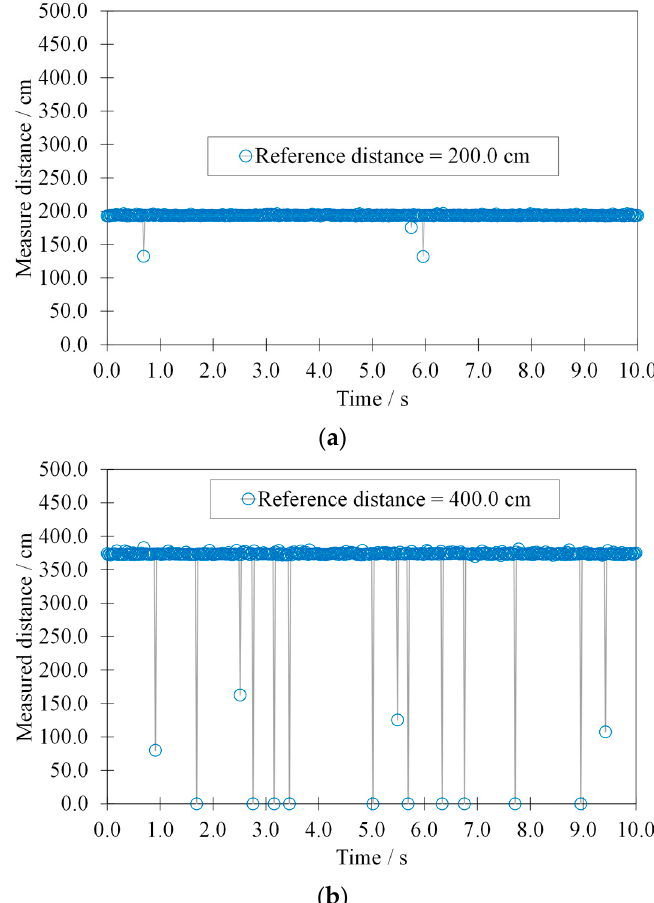
Figure 5. Typical signals: measured distance by the HY-SRF05 at a reference distance of ( a ) 200.0 cm and of ( b ) 400.0 cm as a function of time, before the effects of the accelerated aging.